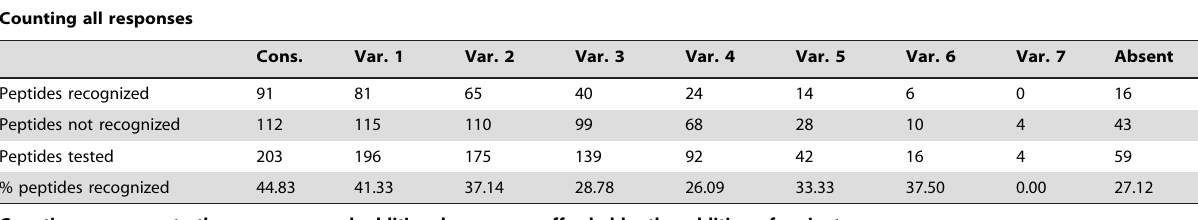
Table 1. ELISpot recognition of consensus and variant peptides.